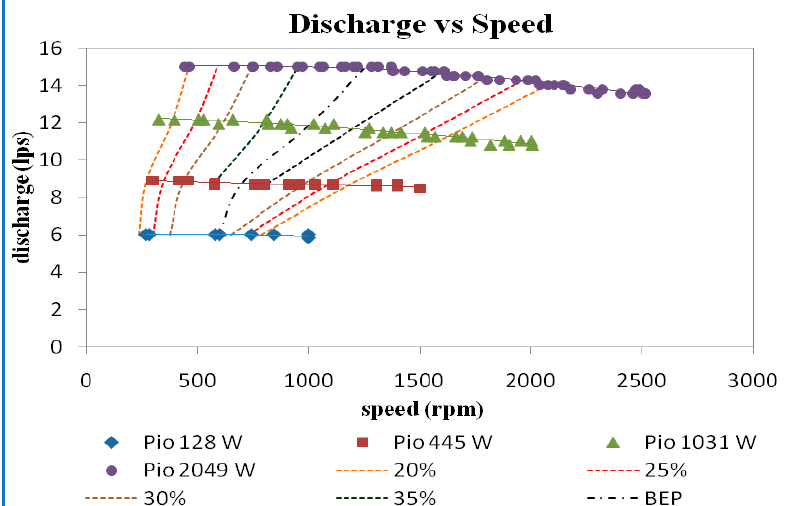
Figure 11. Discharge vs. speed and iso-efficiency line at 10 GVO.